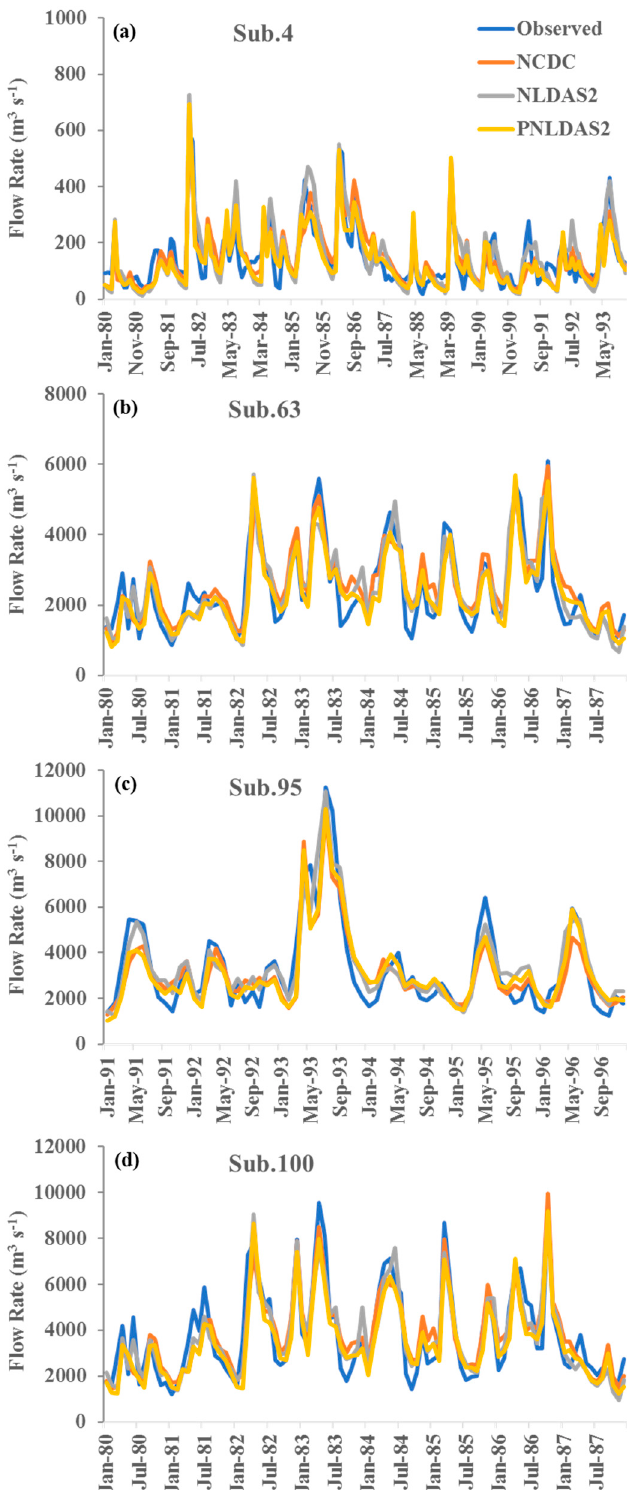
Figure 4. Observed vs. simulated monthly flow rate at the four gauging stations on the main of UMRB during calibration and validation (i.e., USGS 5267000, 5474500, 5513500, and 5587450; see Table 1 for their corresponding sub-basin outlets and evaluation periods).